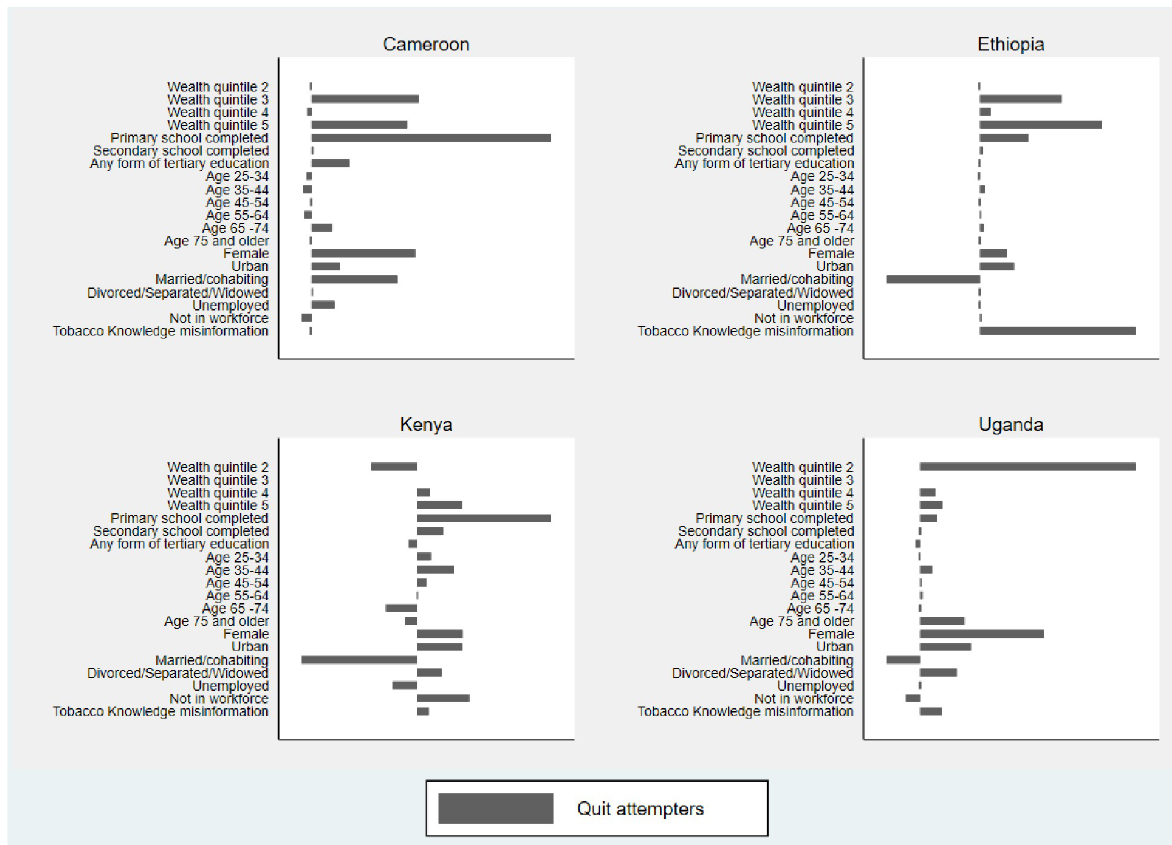
Fig 2. Percentage contribution of x in to wealth-related inequalities in TC